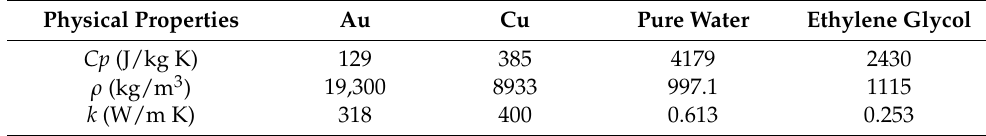
Table 1. Thermo-physical characteristics of water and